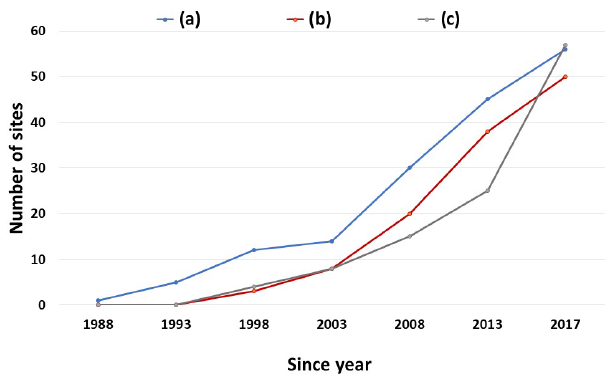
Figure 3. Cumulative number of sites providing information to the WDCA for the aerosol variables: (a) scattering, (b) absorption, and (c) combined size and particle number